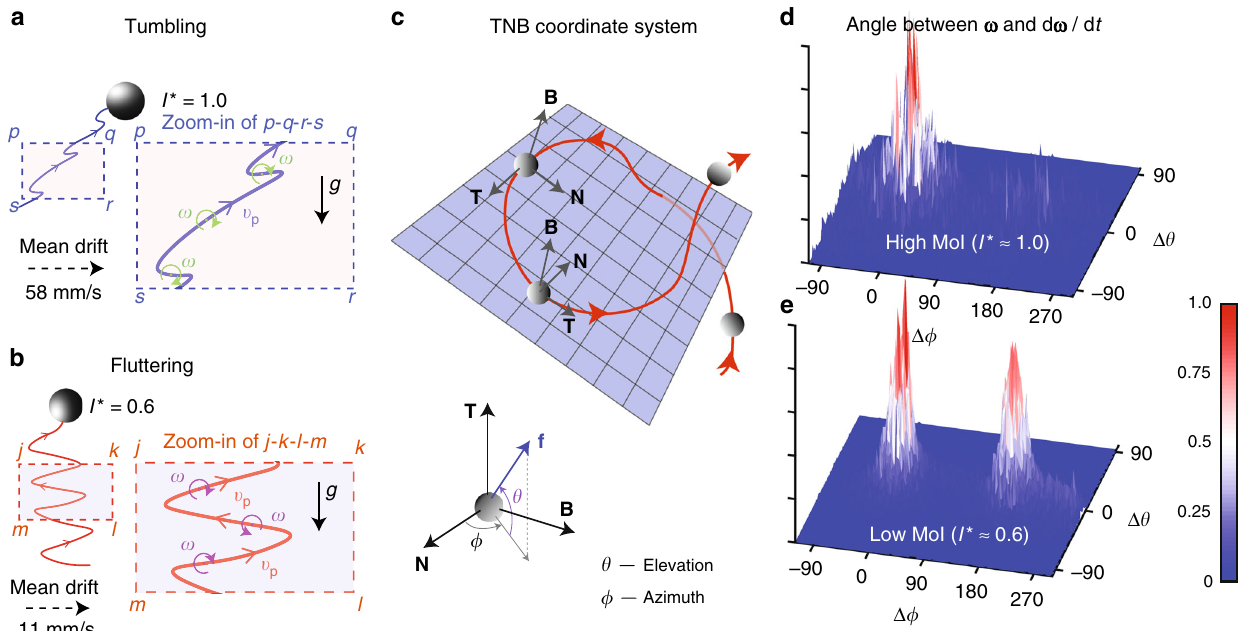
Fig. 2 Tumbling and fl uttering motions of buoyant spheres in turbulence. Drawings representative of a typical trajectory traced by the a high MoI sphere and the b low MoI sphere in a turbulent fl ow at Re λ ≈ 300. The zoomed-in views of the rectangular windows pqrs and jklm are also shown. The high MoI sphere tumbles in the fl ow, where the direction of rotation does not change much during the motion. This tumbling motion induces a mean horizontal drift for the particle. The low MoI sphere fl utters in the fl ow, where the directions of rotation and translation undergo frequent reversals at a rate comparable to that of vortex-shedding frequency. This fl uttering is thought to stabilize its motion to remain vertical to the mean. c Sphere motion transformed into a moving TNB coordinate system, where T — the direction of the particle ’ s instantaneous velocity v , N — direction of curvature of the particle trajectory, and p B — the binormal vector is de fi ned such that N ¼ B ´ T . The lower fi gure shows the TNB coordinate system, where the orientation of an arbitrary vector f can be expressed in terms of the elevation θ and azimuth ϕ angles. d , e Normalized histograms of the angle between the angular velocity vector ω and its time derivative d ω = d t ; expressed in terms of Δ θ and Δ ϕ for the d high and e low MoI spheres, respectively. Supplementary Movies 1 and 2 compare the two types of motion. The typical amplitude of fl utter and tumble is 1 – 2 sphere diameters during an